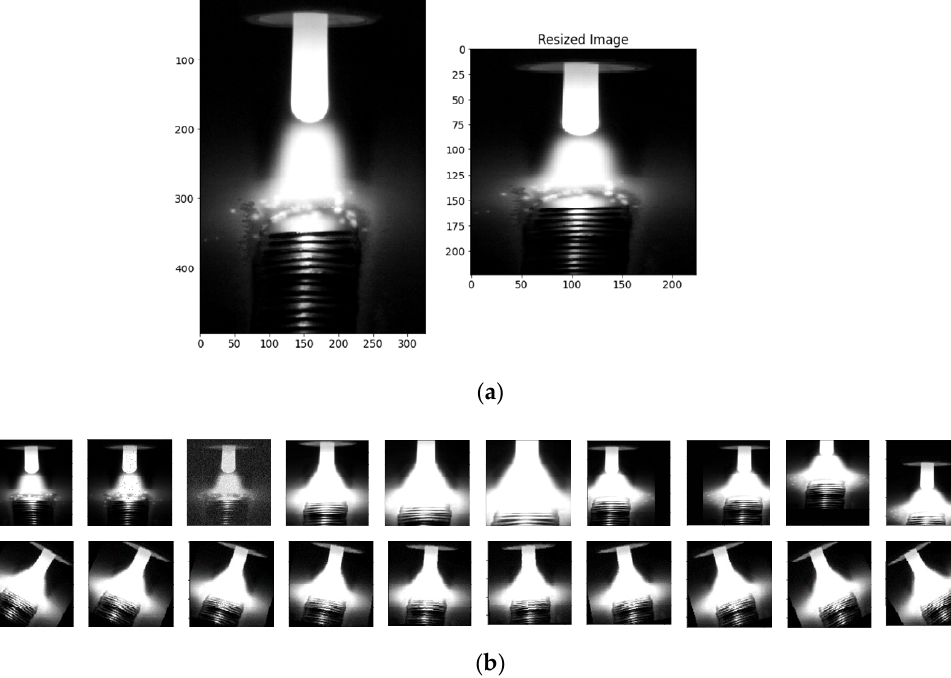
Figure 6. The result of the original image “good” processed by data augmentation. ( a ) the resized image of the original image “good” with a size of 224 × 224 pixels; ( b ) the result in the order of flipping, changing the lighting condition, adding “Salt and Pepper” noise, scaling, translation and rotation. Table 3. The number of images in each category.